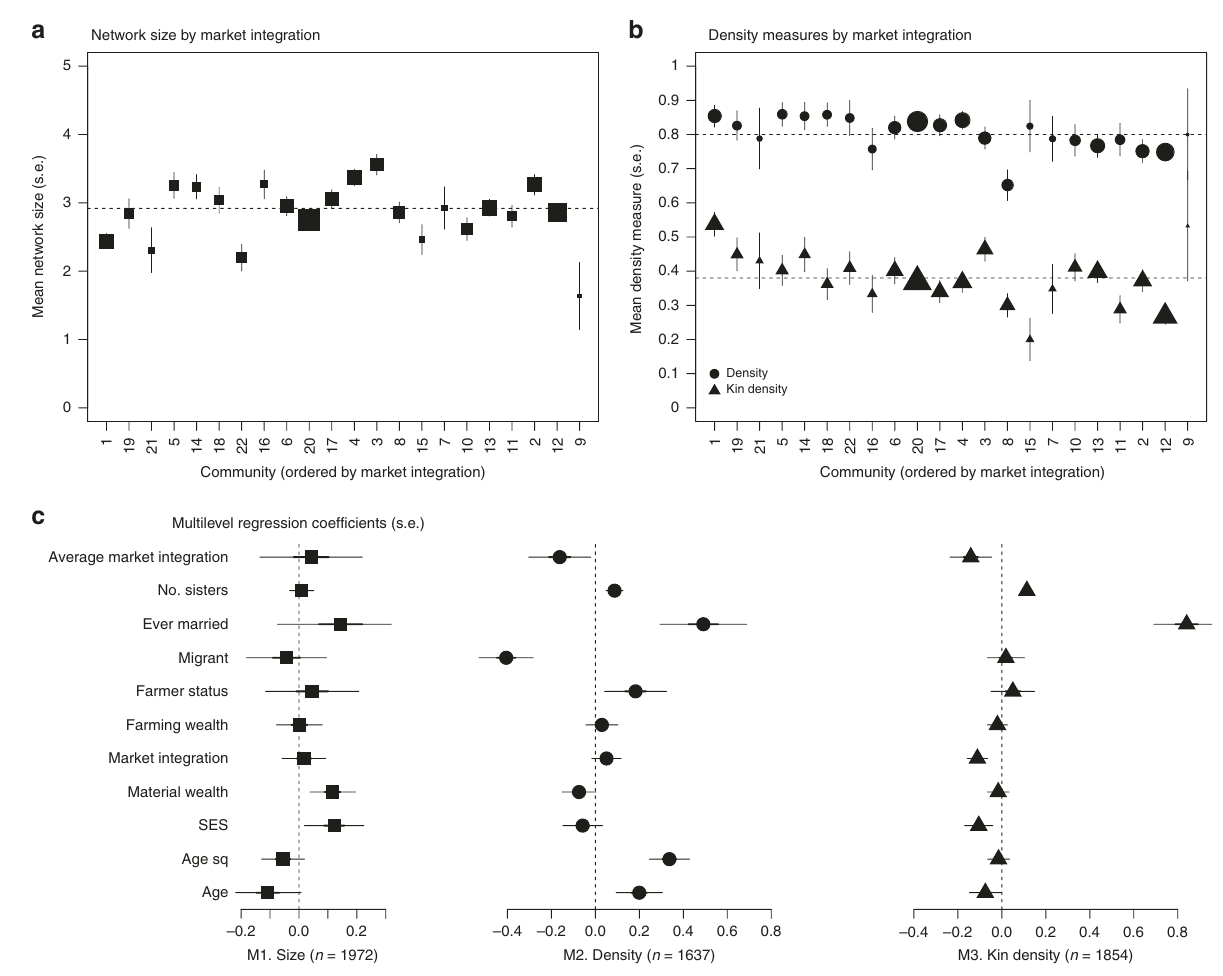
Fig. 3 Community level variation in network characteristics. Panels show a network size and b density/kin density, ordered by average market integration (see Source Data fi le). c shows forest plots of the model-adjusted coef fi cients (ß estimates) and standard errors from the three multilevel models (see Supplementary Table